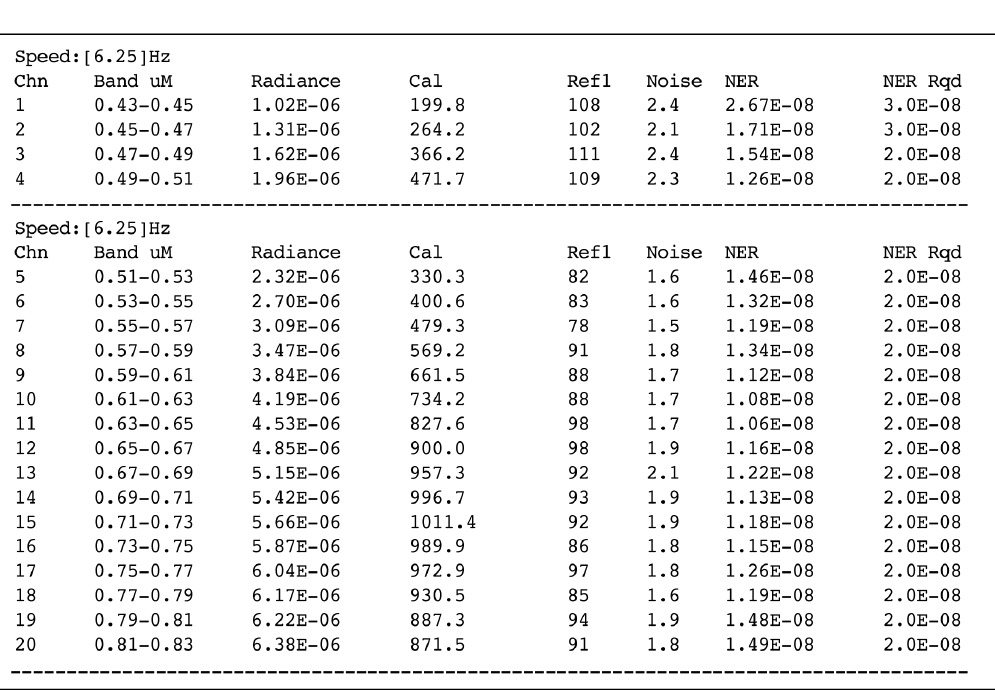
Fig. 1. Example of Acceptance Test Procedure (ATP) self calibration procedure output file for the first 20 MIVIS spectral